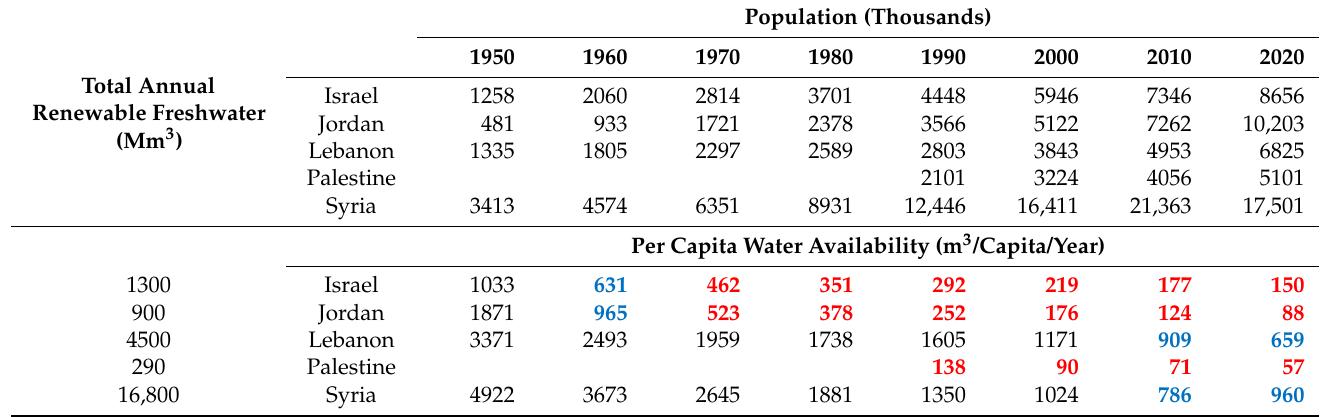
Table 1. Population, Total Natural Renewable Freshwater Resources & Falkenmark Index